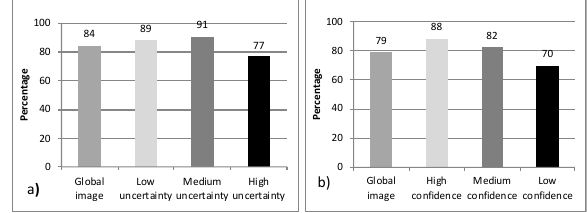
Figure 5. Overall accuracy of: a) the global image and the regions with low, medium and high uncertainty obtained with the RMD uncertainty measure and b) the global image and the regions with high, medium and low confidence Figure 5 shows the overall accuracy obtained for the global image and the regions with the three levels of uncertainty obtained with the RMD and the three levels of confidence.